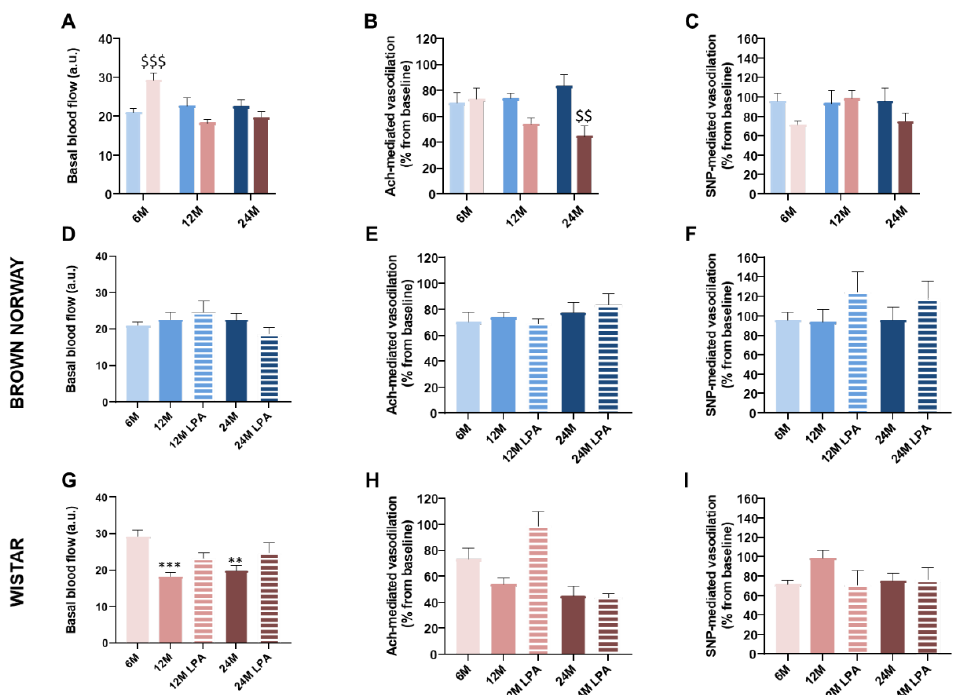
Figure 6. Evolution of the endothelial function over time with (hatched bars) or without (solid bars) LPA treatment. The effect of acetylcholine (Ach) and sodium nitroprusside (SNP) iontophoresis were analyzed in both BN (in blue) and Wistar (in pick) strains for 6 month old (6 M), 12 month old (12 M), and 24 month old (24 M) rats previously fed a diet supplemented with α -lipoic acid (0.5%) for 4 weeks (LPA) or not. A comparison between the two strains was also performed for each parameter ( A – C ). In each condition, basal blood flow was measured 1 min prior to Ach or SNP iontophoresis ( A , D , G ). From the skin blood flow changes, the vasodilation (percentage increase from baseline) was calculated in response to Ach iontophoresis ( B , E , H ) or to SNP iontophoresis ( C , F , I ). Error bars represent the standard error of the mean. Statistical analyses were performed revealing significant differences between the two strains for each age group ($$ p < 0.01; $$$ p < 0.001 vs. BN strain) or during skin aging when compared to the 6 month condition (** p < 0.01; *** p < 0.001). In healthy skin, local iontophoretic delivery of Ach to the skin is known to induce an endothelium-dependent vasodilation. Indeed, Ach is the most commonly used pharma-